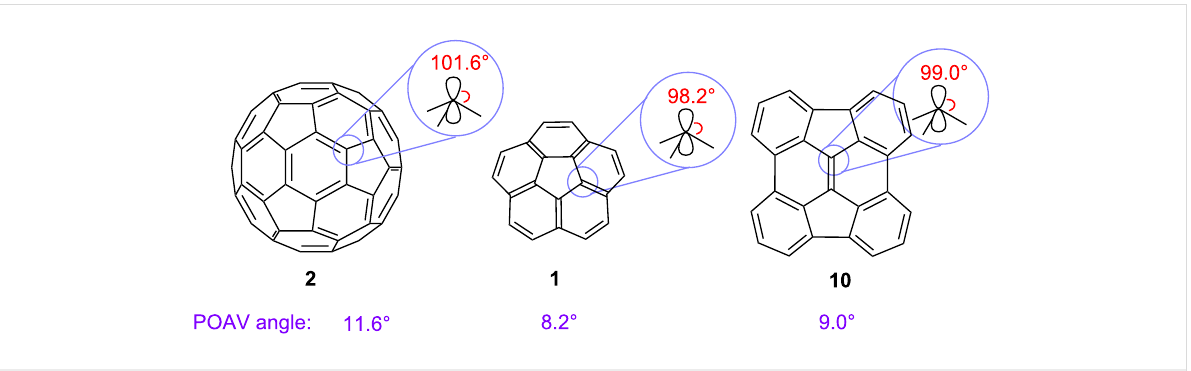
Figure 4: POAV angles of fullerene C 60 ( 2 ), corannulene ( 1 ), and diindenochrysene ( 10 ).